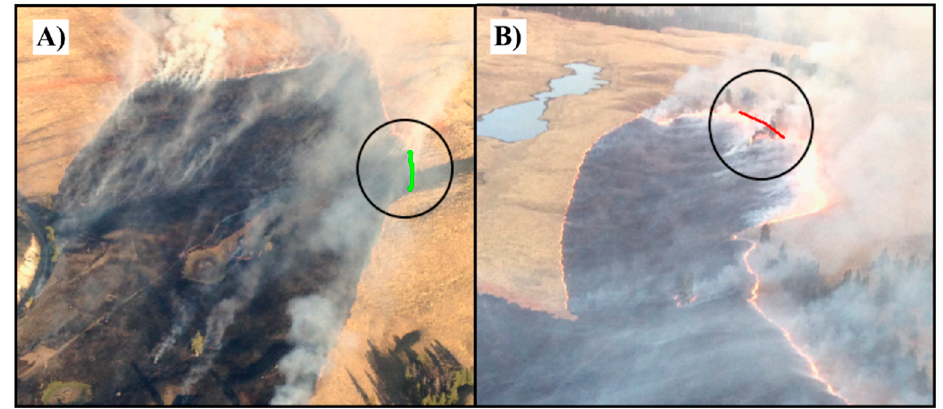
Figure 6. ( A ) Start fire front position (green line); ( B ) end fire front position (red line) at Site #3.